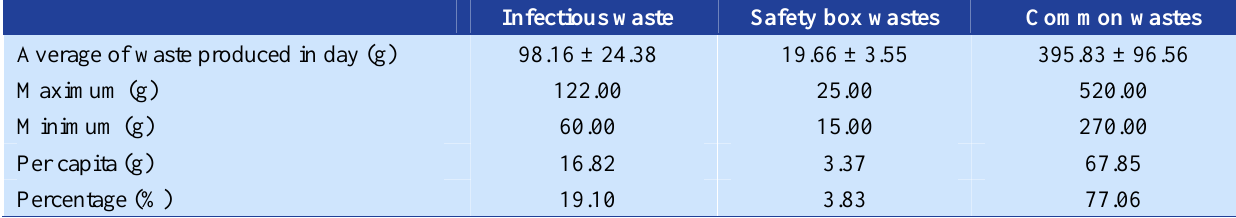
Table 1. Produced waste in dental offices of Sari with 6 ± 2 visited persons per